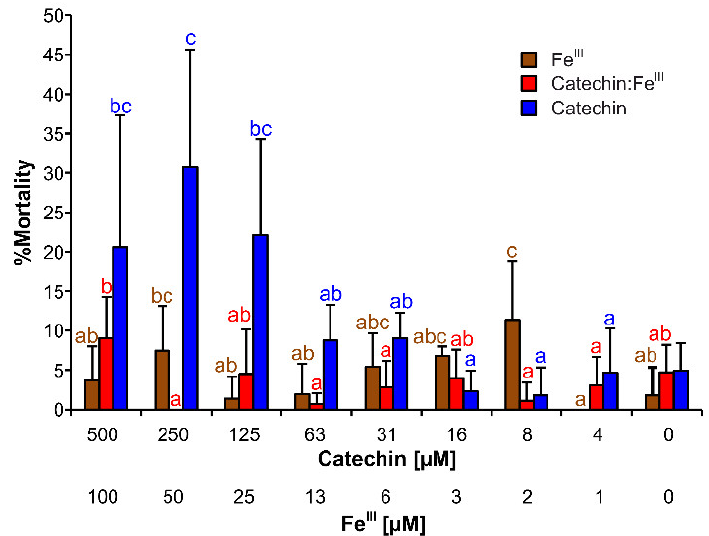
Figure 8. Brine shrimp ( Artemia salina L.) mortality caused by ( ± )-catechin in noncoordinated form and as Fe–catechin complexes. The upper scale designates the concentration of ( ± )-catechin, the lower one designates the concentration of Fe III in the tested solution. The bars represent means of eight replicates ( ± SD). The different significance levels were determined by Duncan’s post hoc test (95%) and are indicated by the letters a–e above the error